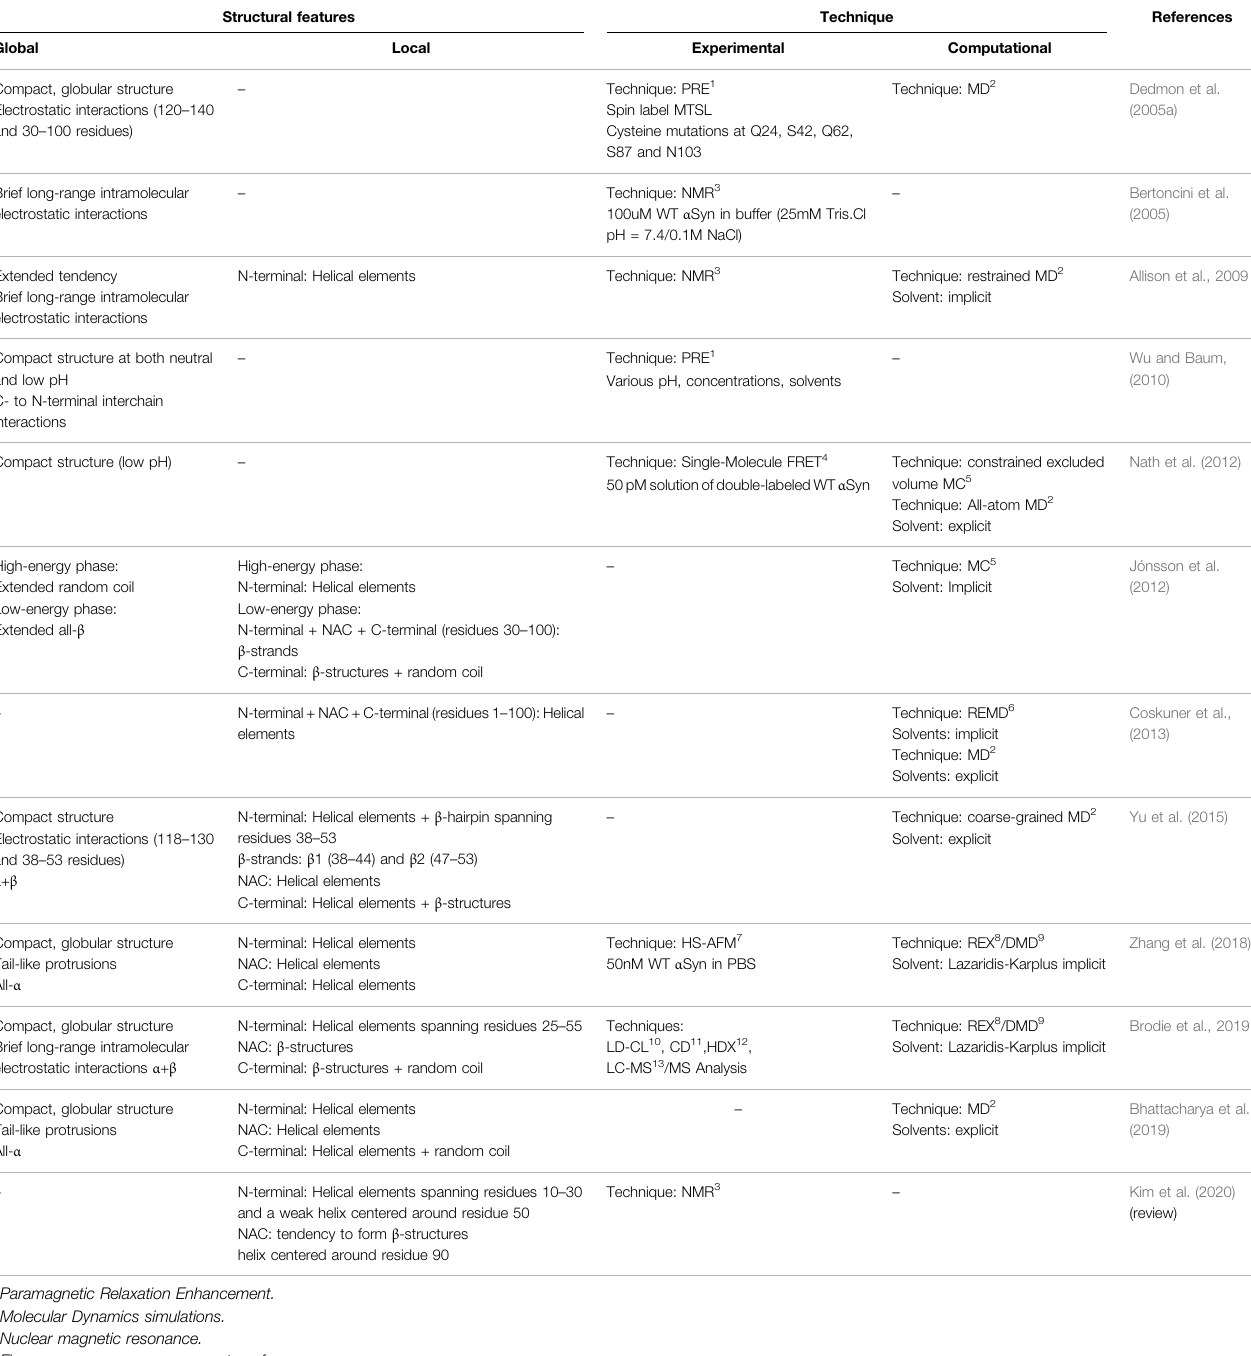
TABLE 1 | Reported experimental and computational data on monomeric wt α